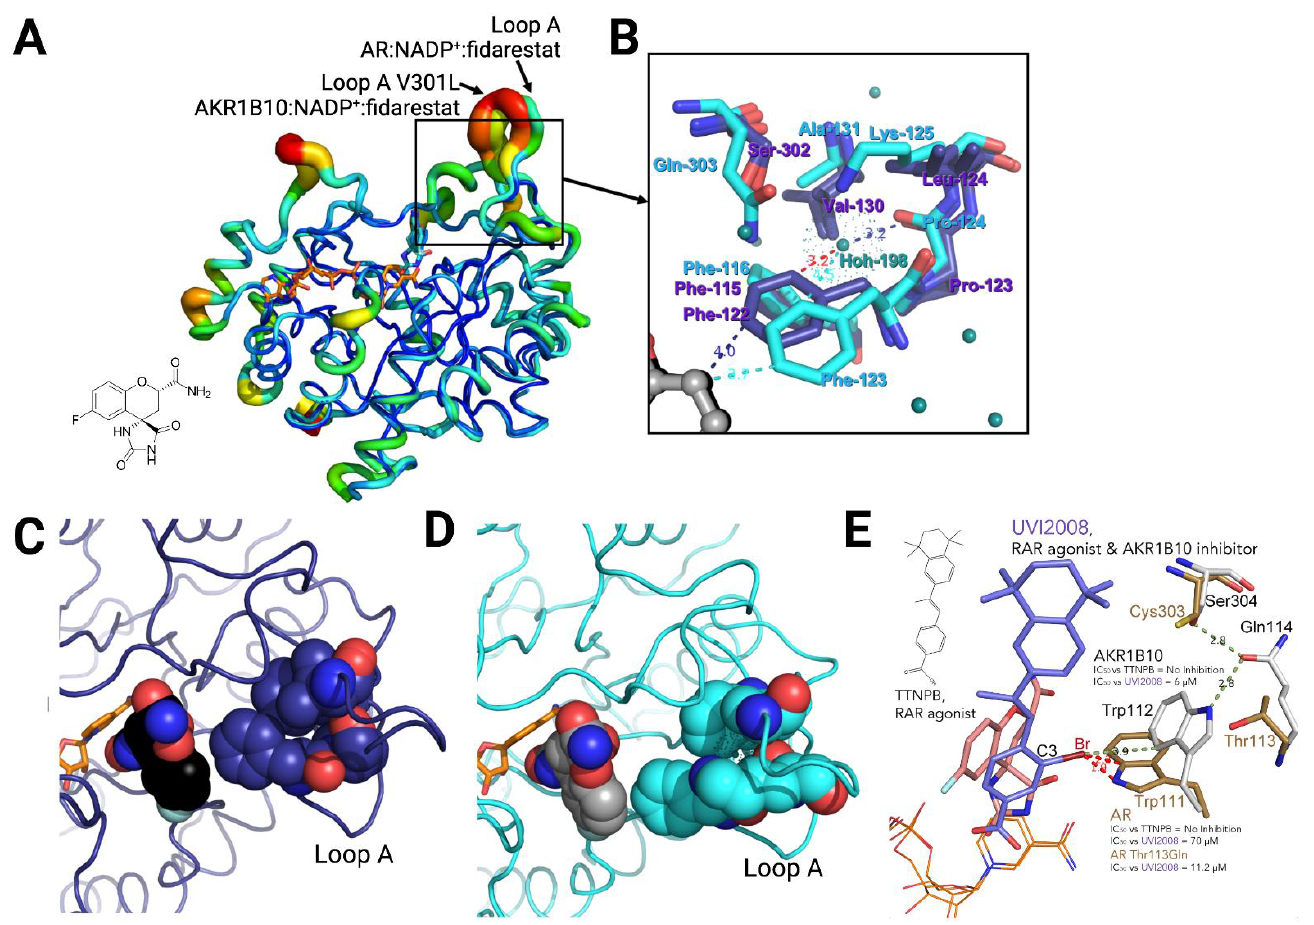
Figure 3. Specific features of AKR1B10 three-dimensional structure. ( A ) AR:NADP + :fidarestat and V301L AKR1B10:NADP + :fidarestat complexes in cartoon representation in B-factor putty mode to reflect the thermal flexibility